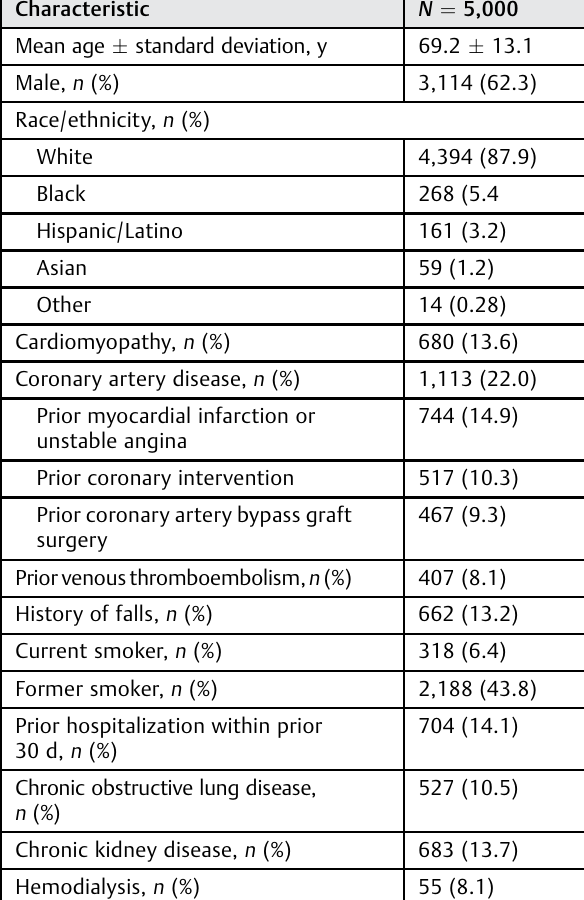
Table 1 Baseline demographic and clinical characteristics Characteristic